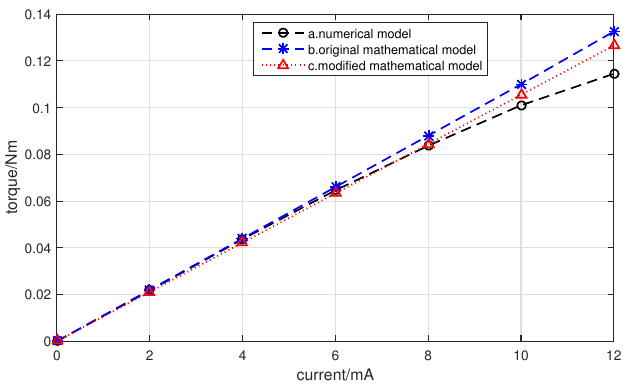
Figure 15. Torque output from the numerical result, the conventional model and the modified